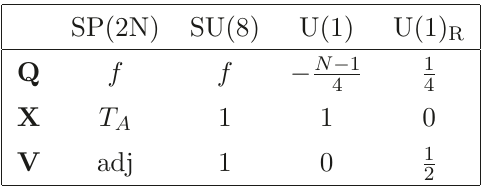
= 1 theory with SP(2N) gauge symmetry and SU(8) N